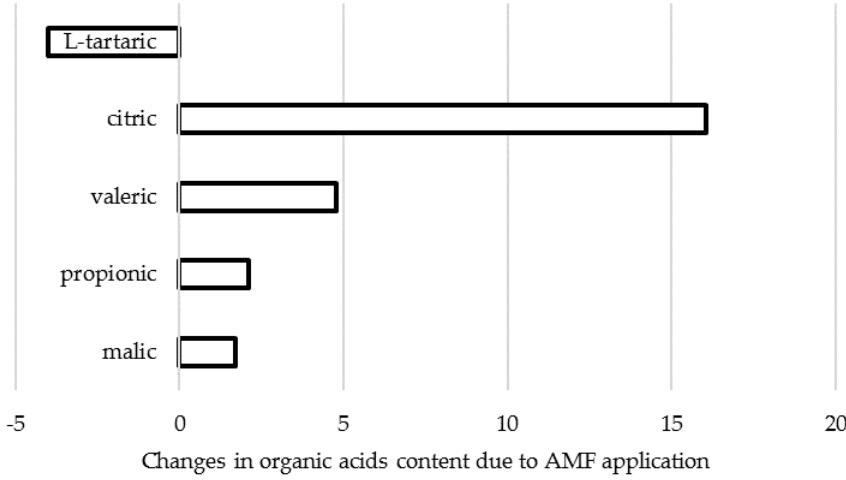
Figure 3. Changes in organic acids content in A. cepa cultivar Wolska upon AMF ( Rhizophagus irregularis ) inoculation (data re-elaborated from Rozp ˛adek et al., 2016 [74]).